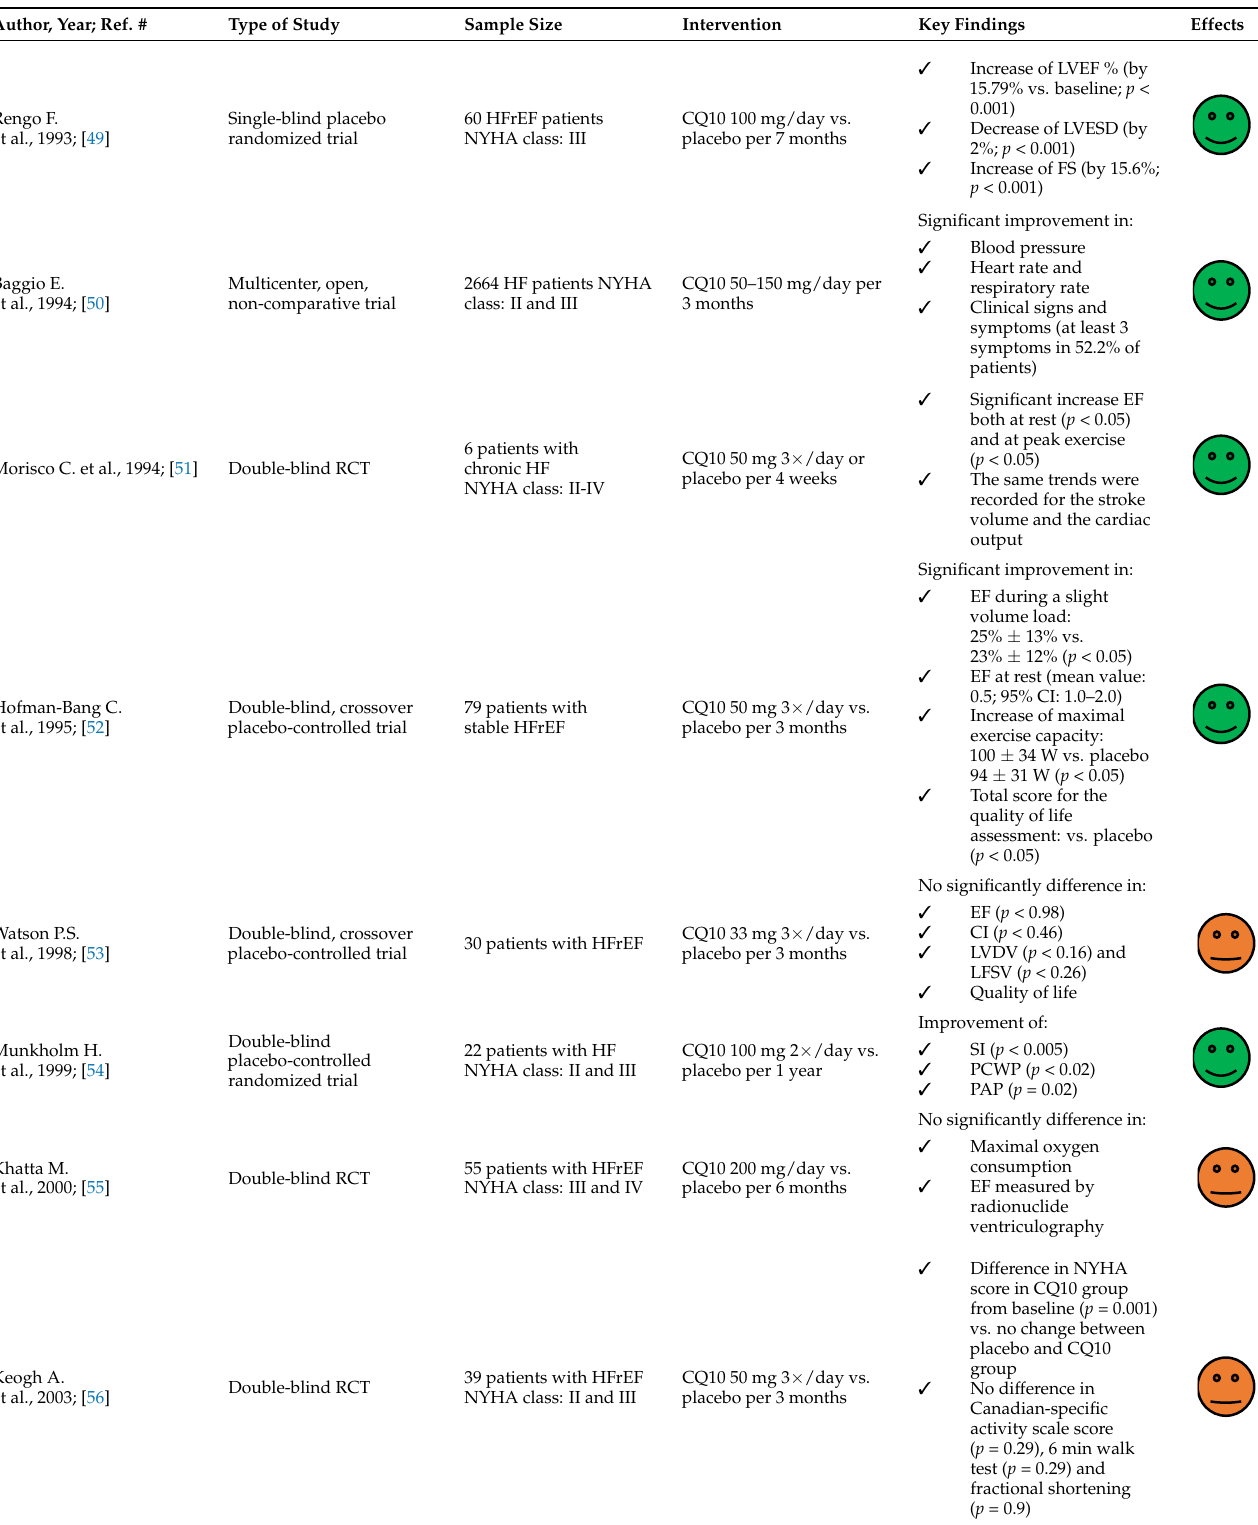
Table 2. Studies evaluating the effectiveness of CoQ10 supplementation in the treatment of HF. The only studies with multicenter, prospective, randomized, double blinded, placebo controlled, soft and hard endpoints protocols are bolded; the ones with all-cause mortality reduction positive re- sults are in red among those. Superiority (smiling, green faces) on the contrary to inferiority ones (non-smiling, orange faces) were put by the authors judging objectively the findings of coenzyme